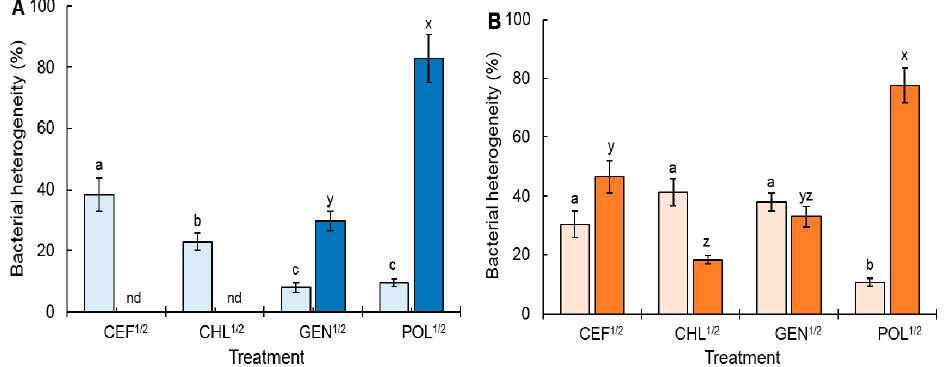
Figure 2. Frequencies of persistence ( ■ , ■ ) and resistance ( ■ , ■ ) in Salmonella Typhimurium ATCC 19585 (ST ATCC ; A ) and S . Typhimurium CCARM 8009 (ST CCARM : B ) exposed to a half minimum inhibitory concentration (MIC) of cefotaxime (CEF 1/2 ), chloramphenicol (CHL 1/2 ), gentamicin (GEN 1/2 ), and polymyxin B (POL 1/2 ). Different letters (a–c) on the bars show significant differences among treatments within persistence at p < 0.05, and different letters (x–z) on the bars show significant difference among treatments within resistance at p < 0.05. nd represents not determined.